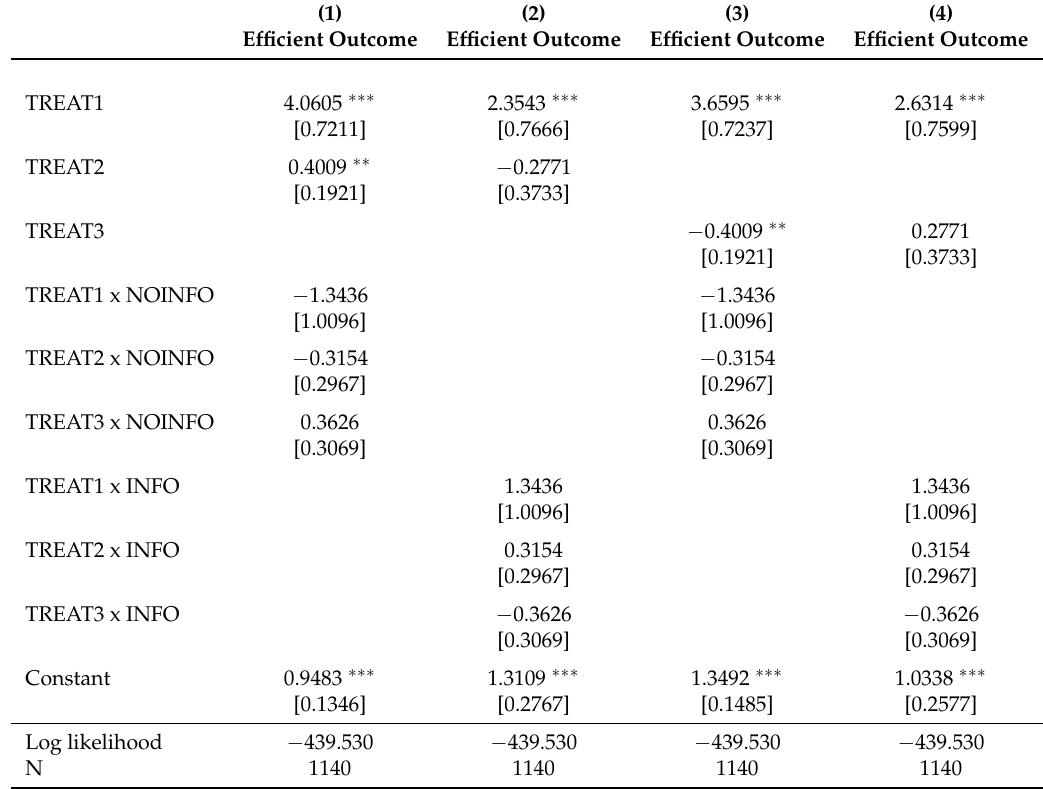
Table 11. Treatment and information effects (posting posteriors) on